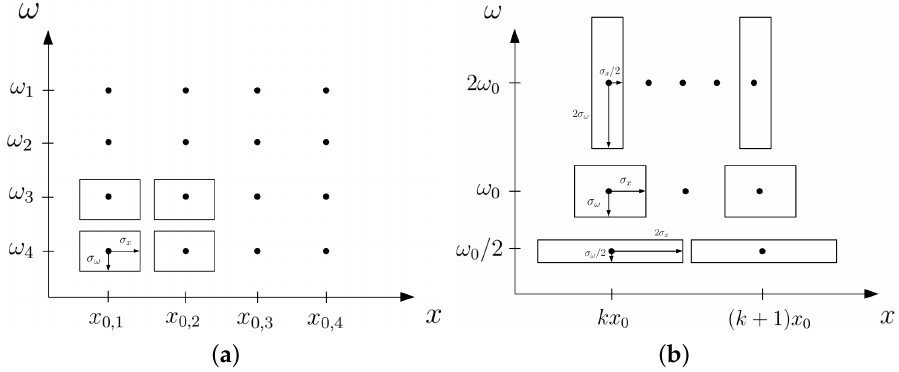
Figure 5. Diagram of observation cells and variable mesh in the 2D dimension x / ω ( a ) Fourier representation ( b ) Wavelet